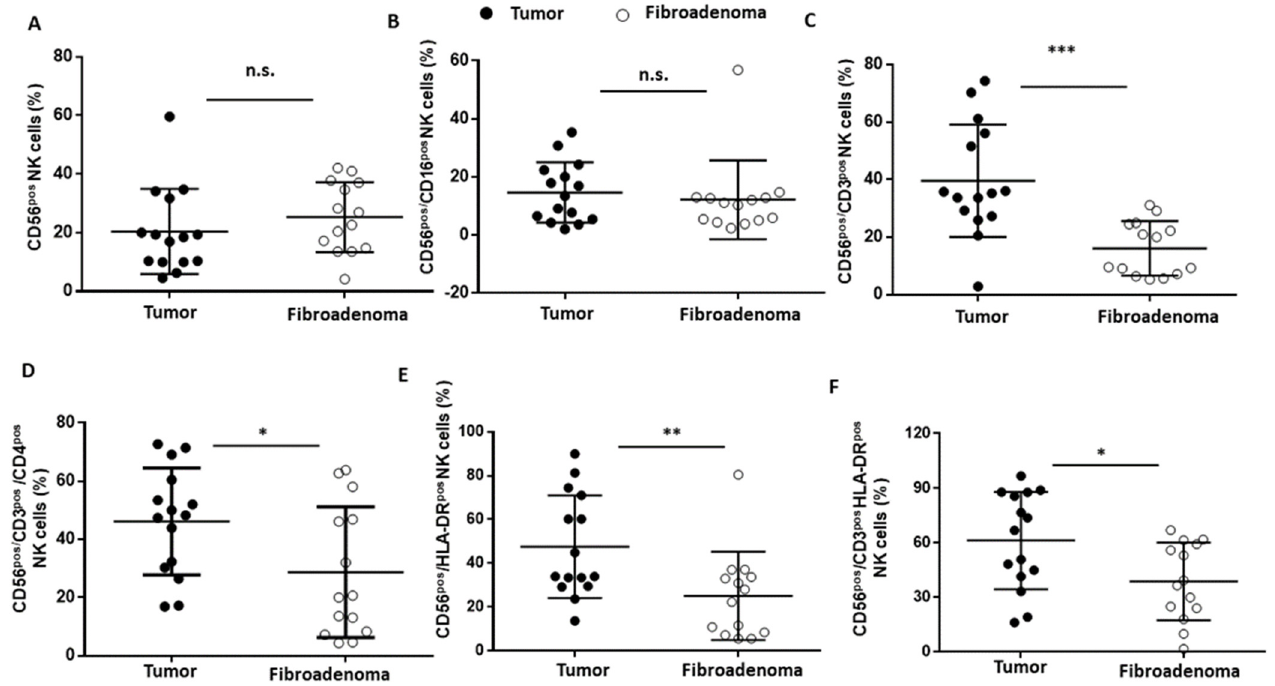
Figure 7. NK cell subset percentages were plotted according to the specific membrane receptor, in tumor (black dots) and fibroadenoma (white dots) tissue patients. ( A ) CD56 pos NK cells. ( B ) CD56 pos /CD16 pos cytotoxic NK cells. ( C ) CD56 pos /CD3 pos NK-T cells. ( D ) CD56 pos /CD3 pos /CD4 pos NK cells (NK Type I). ( E ) CD56 pos /HLA-DR pos NK cells. ( F ) CD56 pos /CD3 pos /HLA-DR pos NK cells. The median and standard deviation are reported. * = p -value < 0.05, ** = p -value < 0.01, and *** = p -value Table 3. Statistical values of the NK lymphocyte subsets. Values are reported as the median per- centage of gated cells.